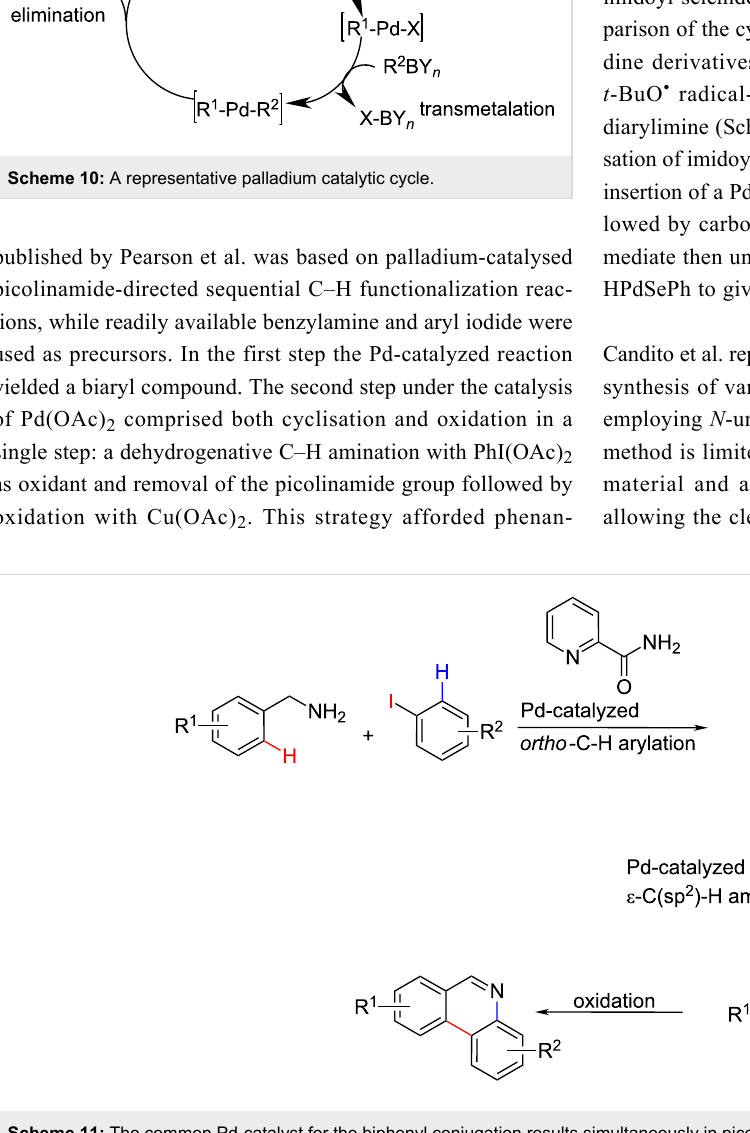
Scheme 11: The common Pd-catalyst for the biphenyl conjugation results simultaneously in picolinamide-directed cyclisation; obtained N -picolin- amide dihydrophenanthridine is easily converted to phenanthridine [32].